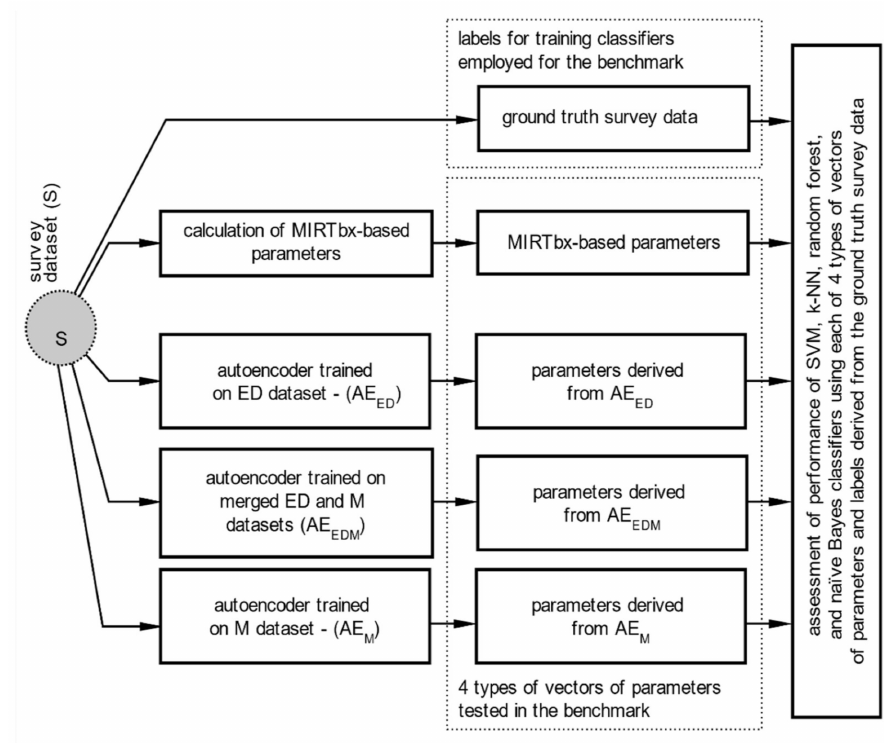
Figure 7. Diagram of the evaluation procedure. Parameters calculated with the MIRtoolbox, AE ED , AE EDM , and A EM autoencoders are fed into a set of selected classifiers. The labels are derived based on answers given by survey participants. The classification algorithms used were as